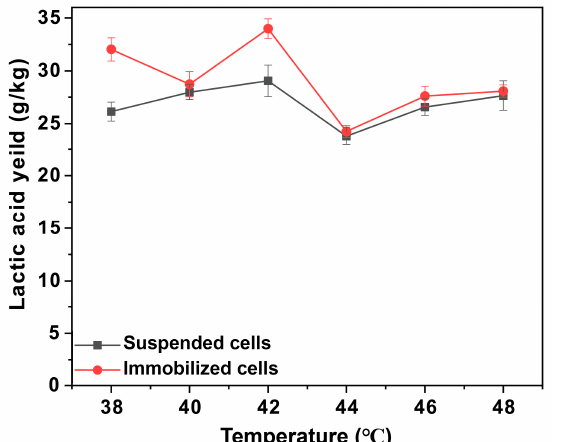
Figure 5. The L -lactic acid concentration for P. acidilactici immobilized PHI-1090 fermented at different temperatures.